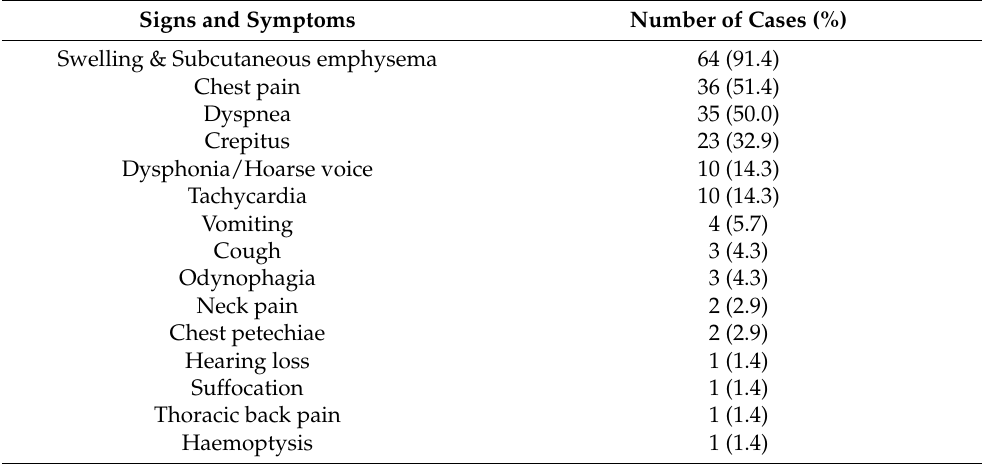
Table 3. Clinical presentation of pregnancy-associated SPM (Total number = 70, not reported = 10).